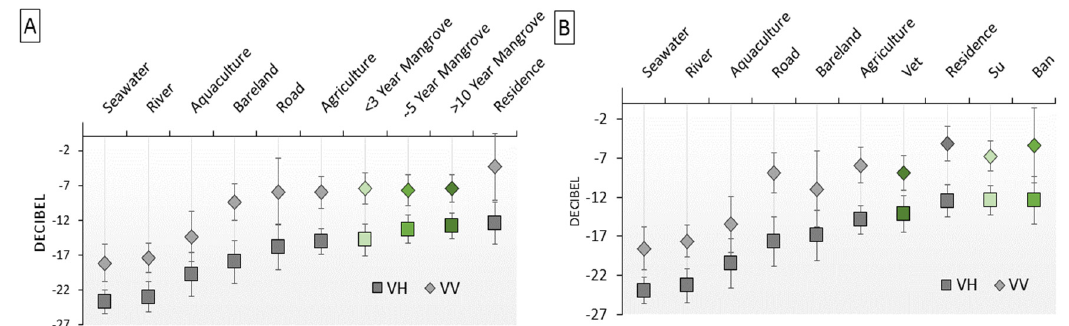
Figure 9. Sentinel-1 VH and VV backscatters on different land use and land cover; training data were used for ( A ) mangrove age and ( B ) mangrove species; V and H are vertical and horizontal, respectively, and coupled letters of VH and VV indicate SAR cross-polarizations .